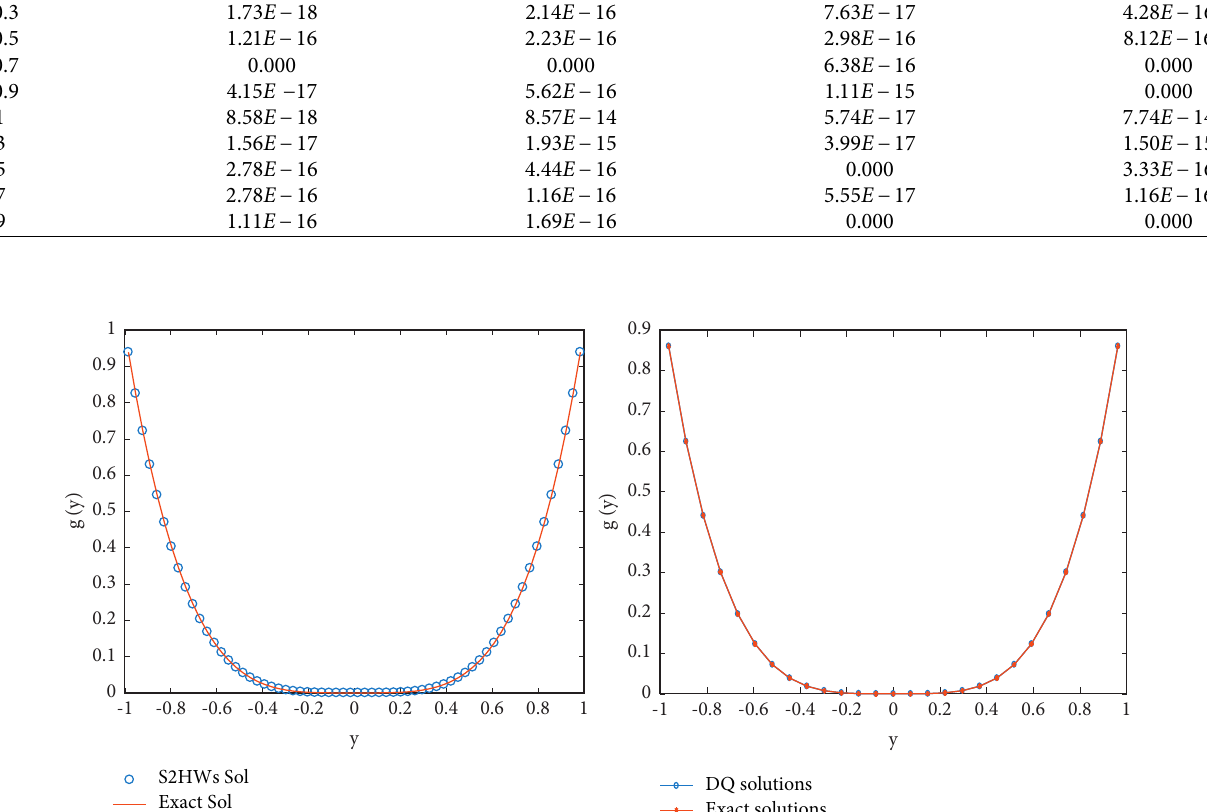
Figure 2: Exact, S2HW, and LIDQT solutions of problem (44) for the parameters φ � 0 . 9 , R � − 1 . 5 , α � − 1 (a